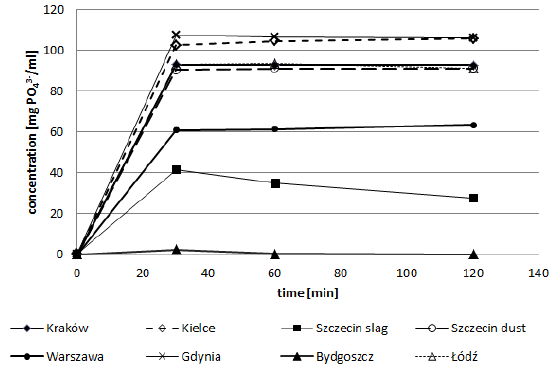
Figure 2: PO 43- concentration in extracts during SSA leaching with 2.7 mol dm -3 HNO . 3